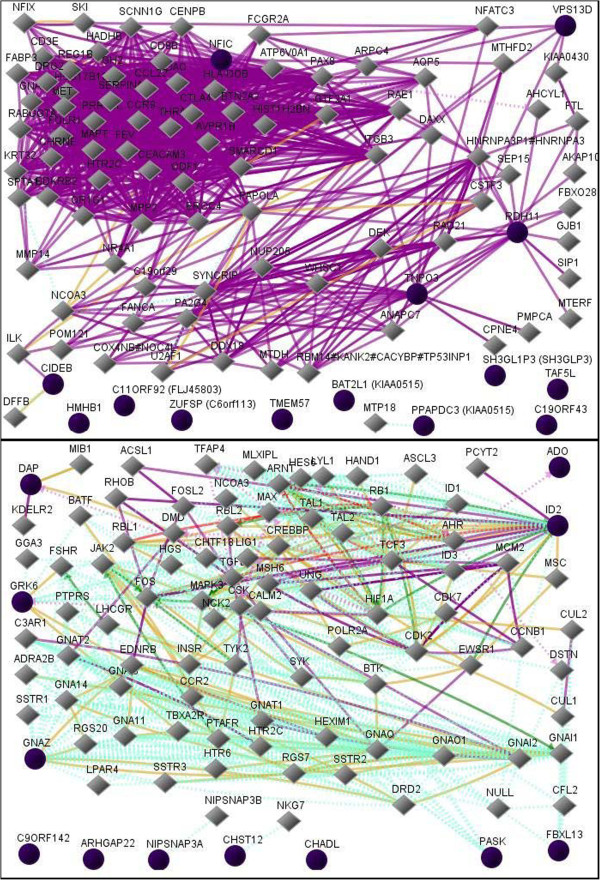
Network diagram of CPE-related genes (top panel) and NCI-related genes (bottom panel) in white matter. Input genes from Table
2 are indicated by solid black circles. The diamond-shapes are neighboring genes that are identified by literature-based associations. There are various types of interactions among the genes represented as lines and dotted lines in color as follows: Down-regulation – red; Up-regulation – green; Regulation – grey; Co-expression – purple; Physical Interaction – brown; Predicted Protein Interaction – dotted aquamarine; Predicted Transcription Factor Regulation – dotted brown.